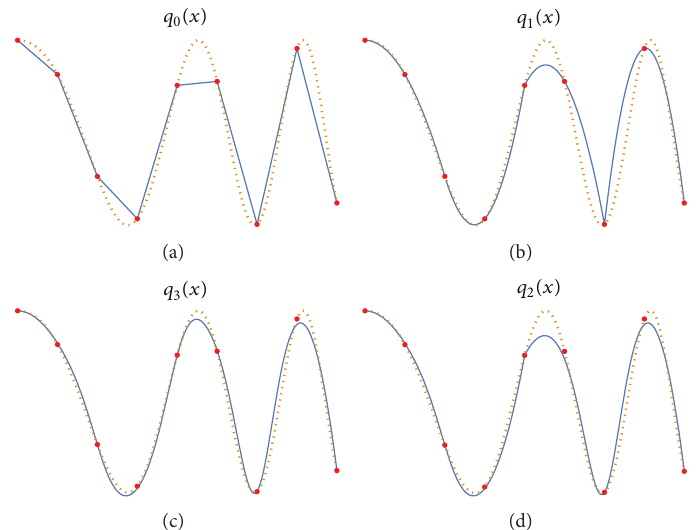
Figure 4: Smoothened piecewise linear interpolation 𝑞 𝑗 (𝑥) , 𝑗 = 0 , 1 , 2 , 3, for the example 𝑓(𝑥) with 𝑁 = 2 3 . The dotted curve indicates the original graph of 𝑓(𝑥)